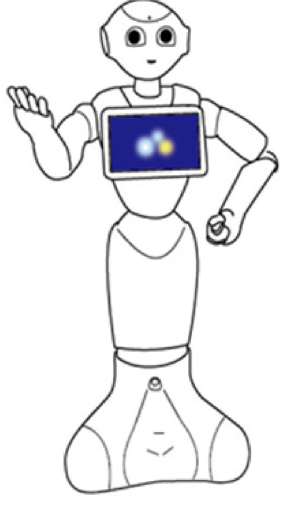
Fig. 1 “Pepper” communication